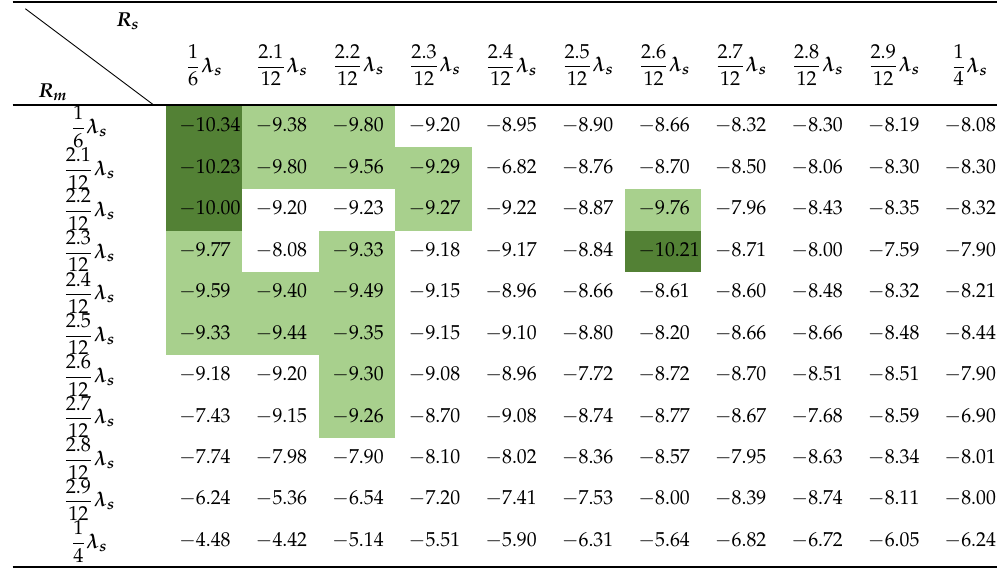
Table 2. Peak S11 values (in dB) of R s , R m